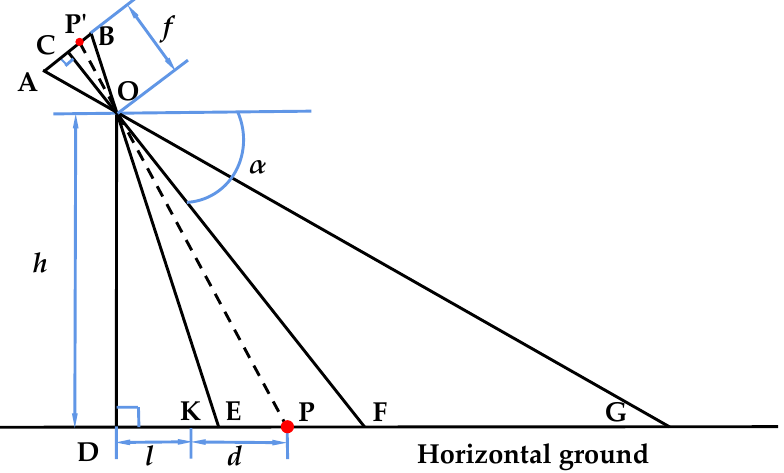
Figure 5. Model of traditional geometric ranging method. In the above figure, P is the feature point of the front vehicle; O is the optical center of the camera; AB is the image plane of the camera; C is the center point of the image plane, and its pixel coordinate is ( u 0 , v 0 ); P’ is the imaging position of P in the camera image plane, and its pixel coordinate is ( u p , v p ). CF is the optical axis of the camera; D is the projection point of the camera on the horizontal ground; G and E are the intersections of the upper edge of the camera image and the ground, and the intersection of the lower edge of the camera image and the ground, respectively; K is the projection point of the front end of the vehicle body on the horizontal ground; l is the longitudinal distance between the camera and the head of the vehicle; h is the height of the camera from the ground; f is the focal length in the pixel; α is the angle between the camera optical axis and the horizontal road surface, that is, the pitch angle of the